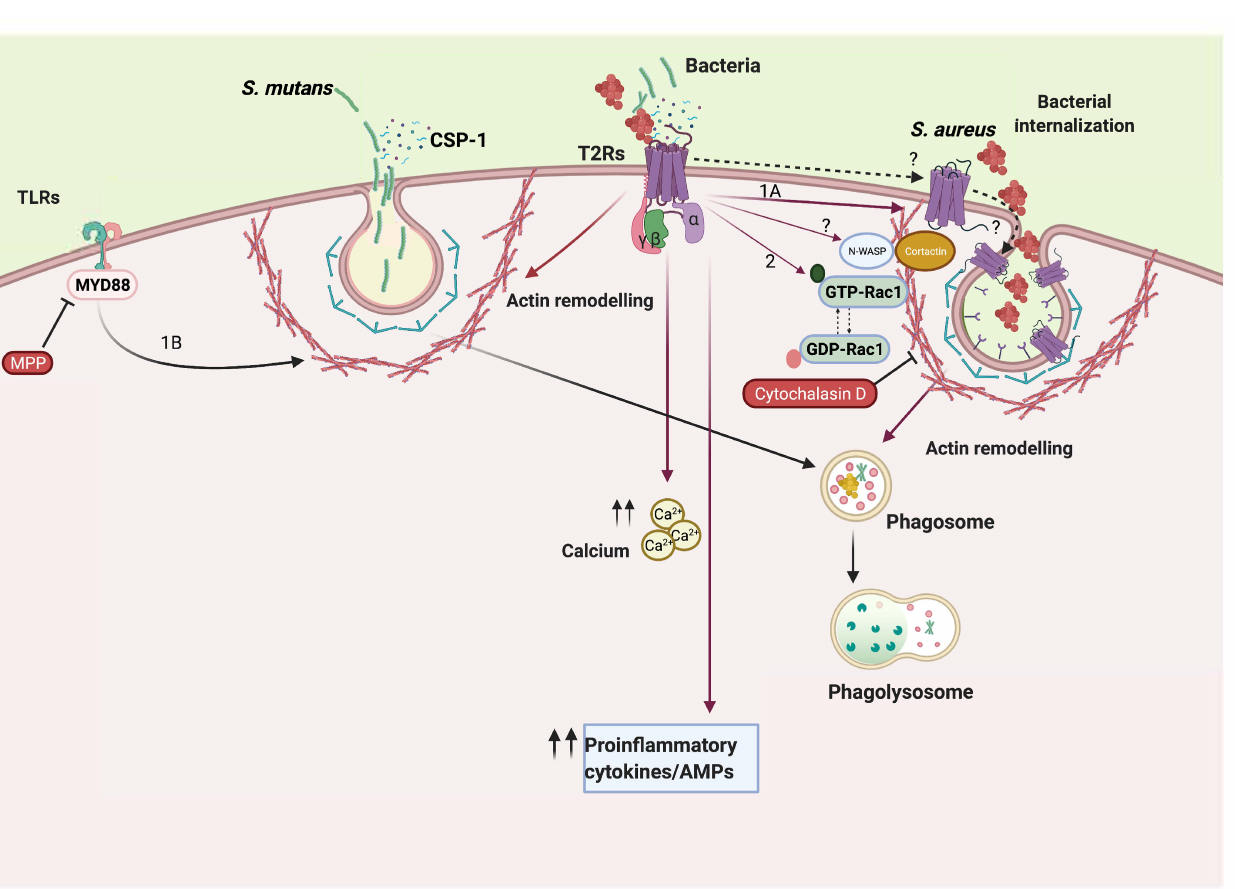
Figure 5. Schematic showing the mechanism of T2R-mediated Gram-positive bacterial internalization and survival in GECs. T2R14-mediated internalization of S. aureus might involve actin remodeling, while S. mutans internalize via T2R/TLR- dependent mechanisms in GECs (pathway (1A,B)). T2R14 in GEC influences actin remodeling (based on cytochalasin D treatment and PAK1-associated actin pull-down), thus modulating bacterial internalization (pathway (2)). The activation to T2R14 signaling by bacteria or their signaling molecules leads to an increased secretion of innate immune markers, such as IL-8/CXCL8 and antimicrobial peptide hBD-2 in GECs. It is currently unknown whether T2R14 internalizes into clathrin-coated vesicles and signals (dotted arrows on the membrane). Figure was drawn by using BioRender, Toronto, ON,